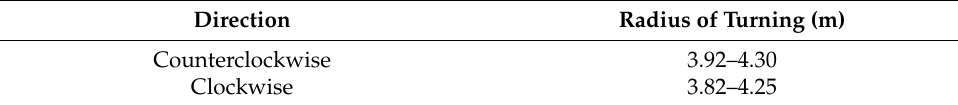
Table 5. Radius of turning of USV2000.